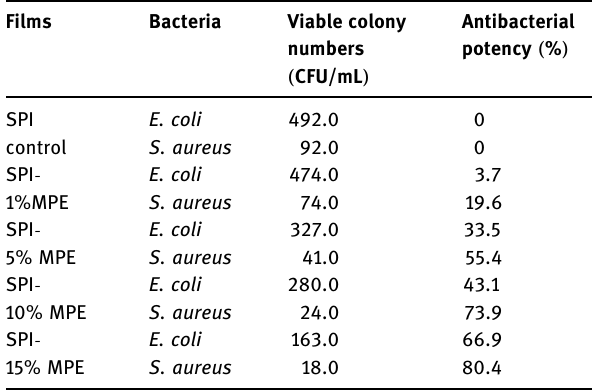
Table 3: Antibacterial properties of SPI fi lms with and without MPE Films